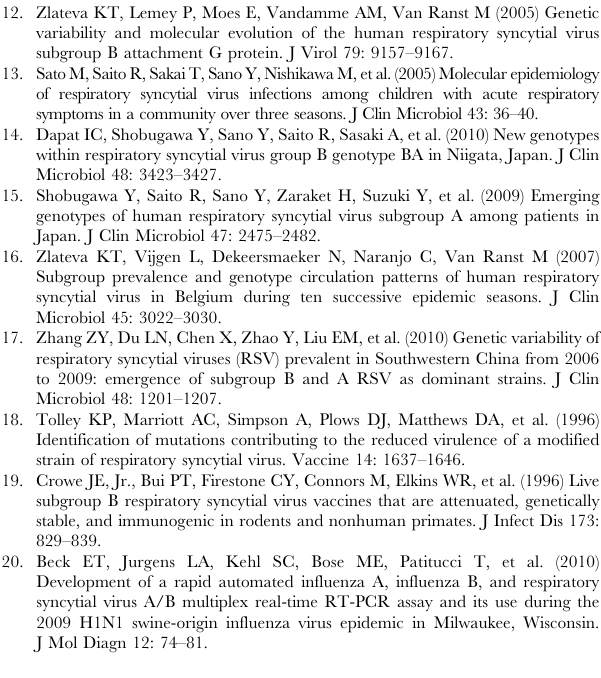
Figure S1 RNA negative-sense genome and amplifica- tion strategy of the whole genome of RSV. At the top the kilobase scale is aligned relative to the RSV genome (approx- imately to scale). Genes are represented as green rectangles named according to the encoded protein. At the bottom the 12 PCR products resulted from the cDNA amplification with 12 overlap- ping primer sets spanning the entire RSV genome. (TIF) Table S1 Primers used for amplification and sequencing.